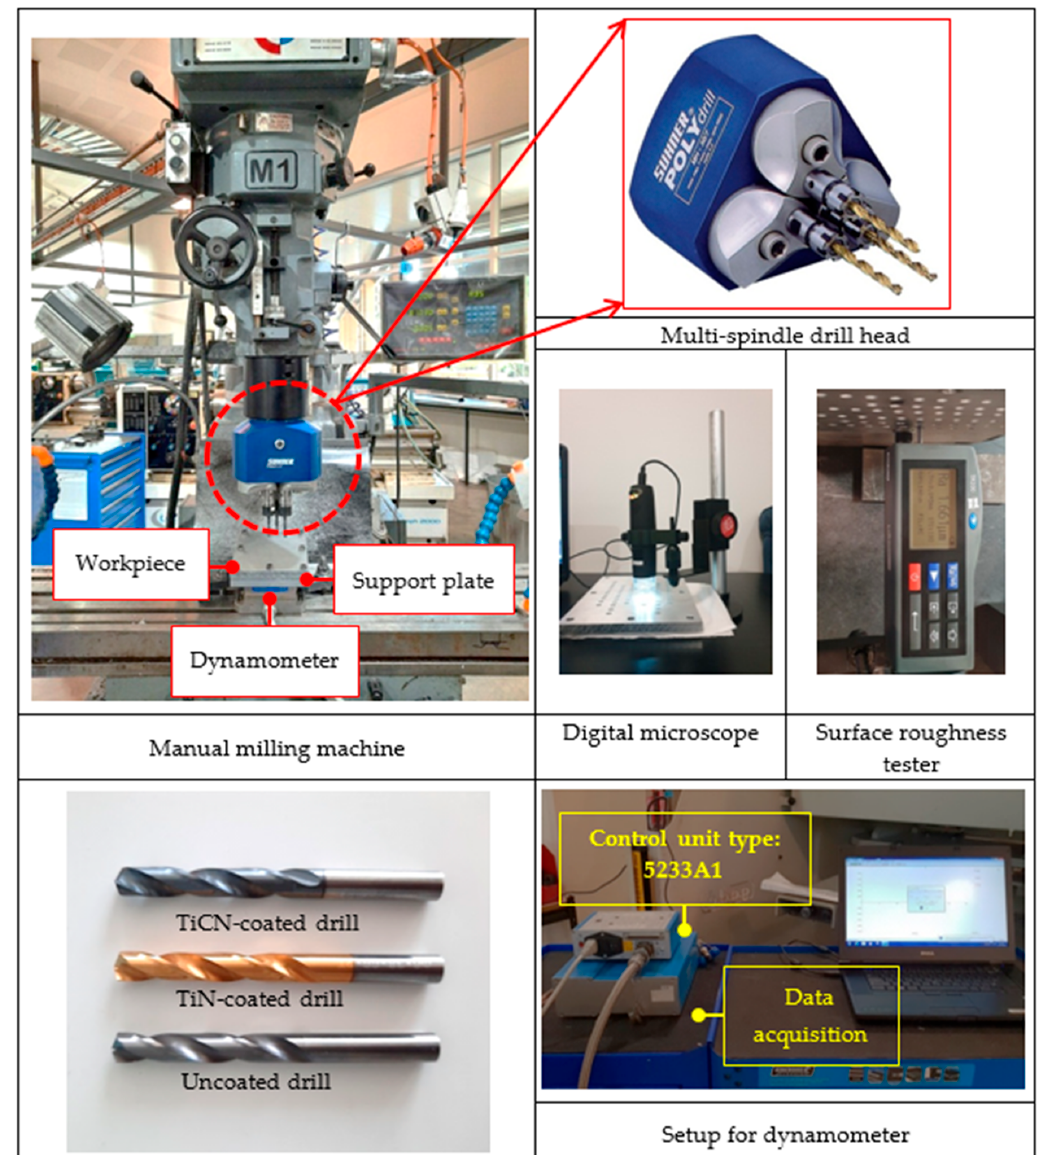
Figure 1. Details of the equipment.